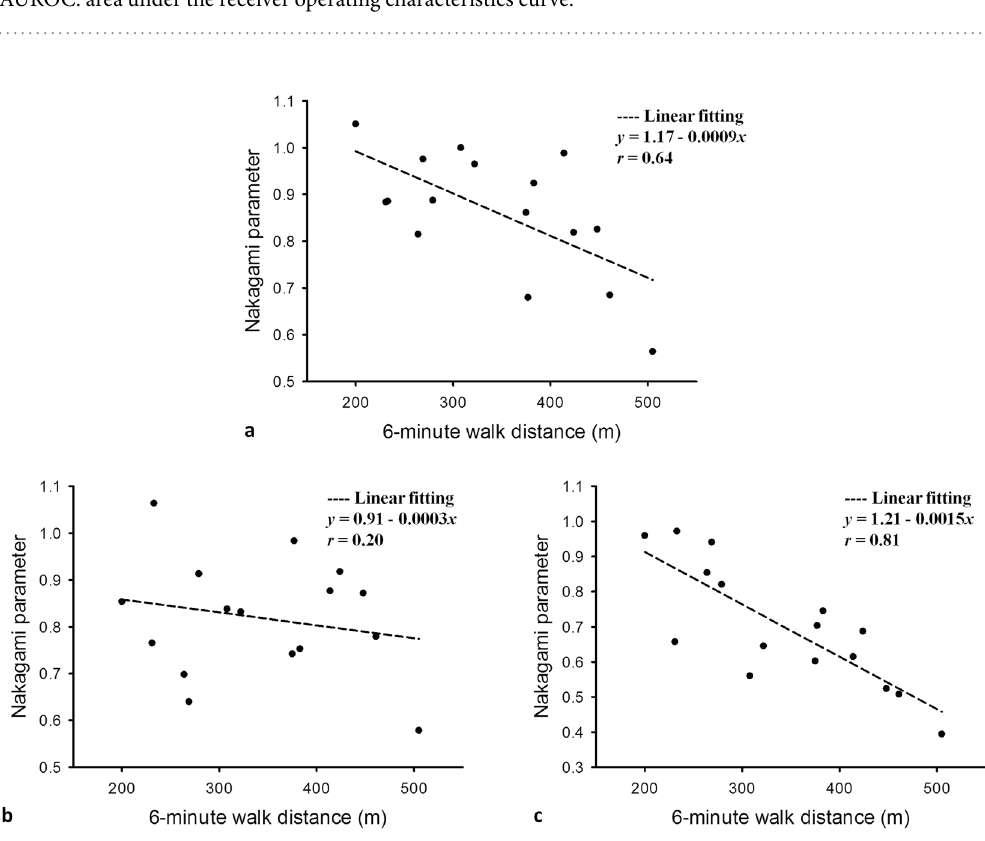
Table 2. Clinical performance of ultrasound Nakagami imaging in diagnosing walking function. LR + : positive likelihood ratio, LR − : negative likelihood ratio, PPV: positive predictive value, NPV: negative predictive value, AUROC: area under the receiver operating characteristics curve.